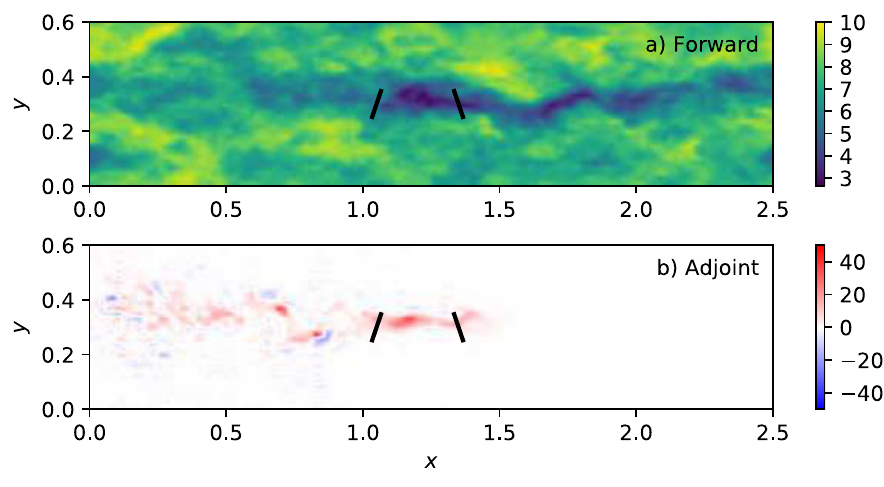
Figure A2. Solution fields for adjoint gradient verification test case at t = 150 s. ( a ) Forward field ˜ u x . ( b ) Adjoint field ξ x .